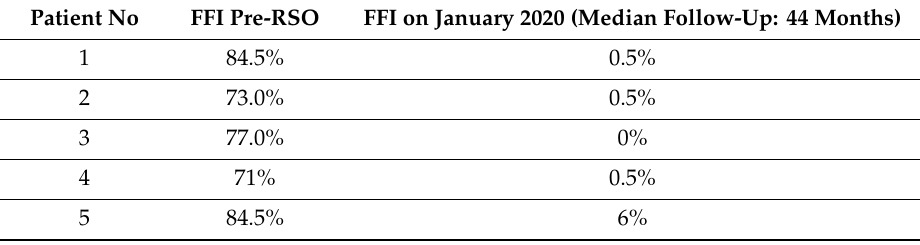
Table 2. FFI before and after treatment of the studied patients.